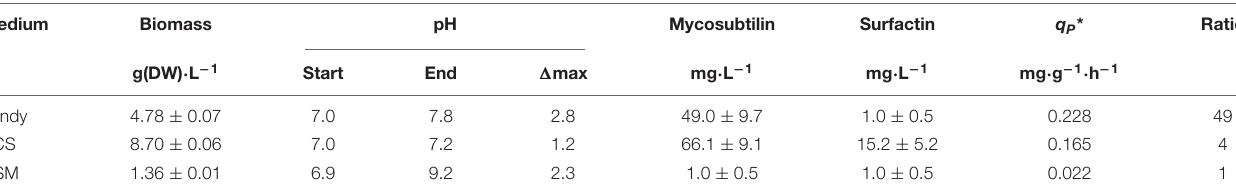
TABLE 2 | Effect of the Landy, ACS, and DSM media on the biomass dry weight concentration, on the pH (culture start, culture end, and maximal pH variation), on mycosubtilin and surfactin concentrations, on mycosubtilin specific productivity, and on the mycosubtilin/surfactin ratio.